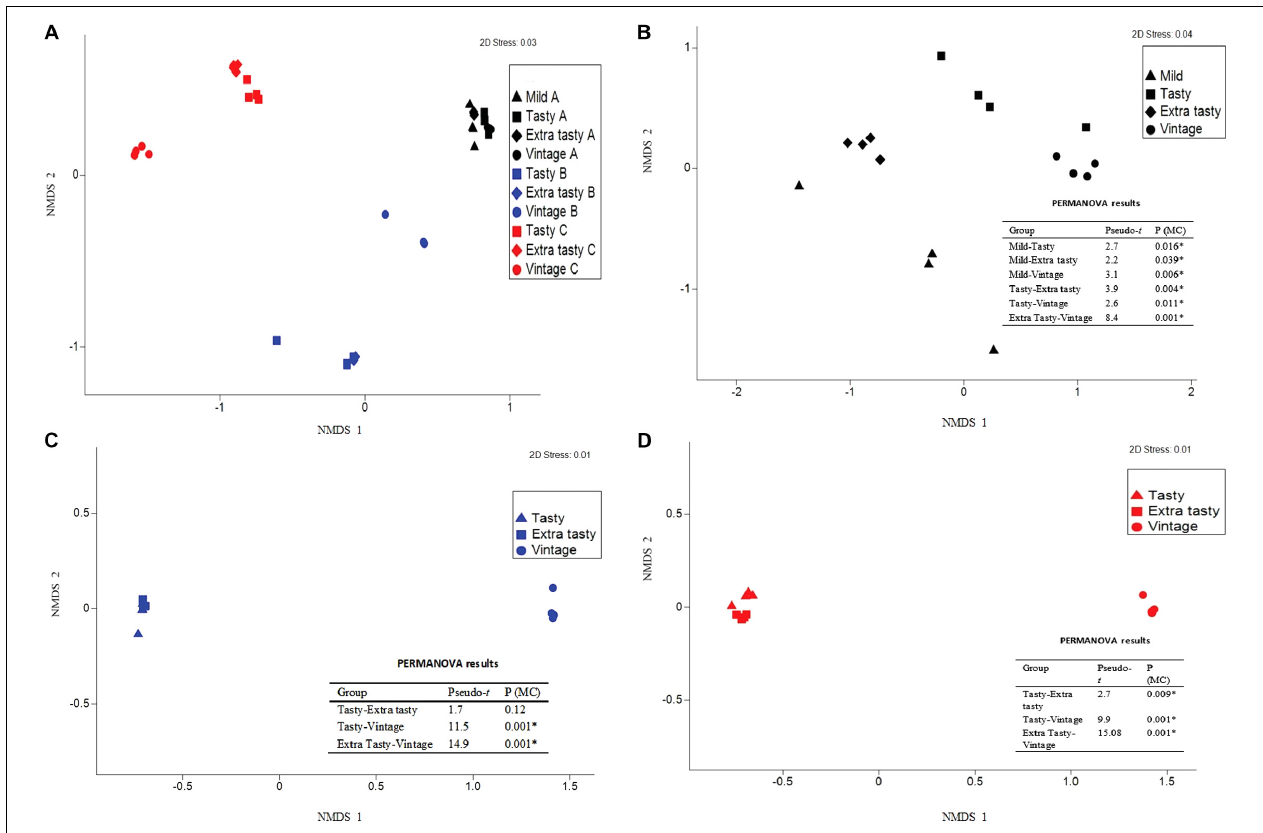
FIGURE 2 | Variation in bacterial community composition in cheese between brands and between cheeses of different maturity. Bray-Curtis non-metric multi-dimensional scaling (nMDS) plots and PERMANOVA results are shown comparing (A) variation between cheeses from different manufacturers and (B–D) variation between cheeses of different maturity for each manufacturer: brand A (B) , brand B (C) , and brand C (D) . Different colors and shapes show different cheese manufactures and different ages, as indicated. PERMANOVA results are shown; Pseudo- t = the Pseudo- t statistic, whereby higher values indicate greater differences between the community structure of cheeses of the two groups compared; P (MC) = Monte Carlo P-value, with significant values ( P < 0.05) indicated by an asterisk.